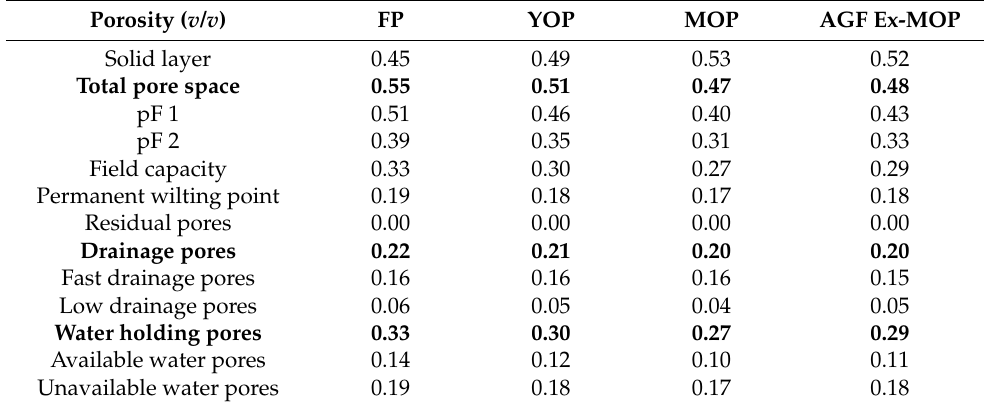
Table 3. Soil water retention characteristic on the same potential for each land